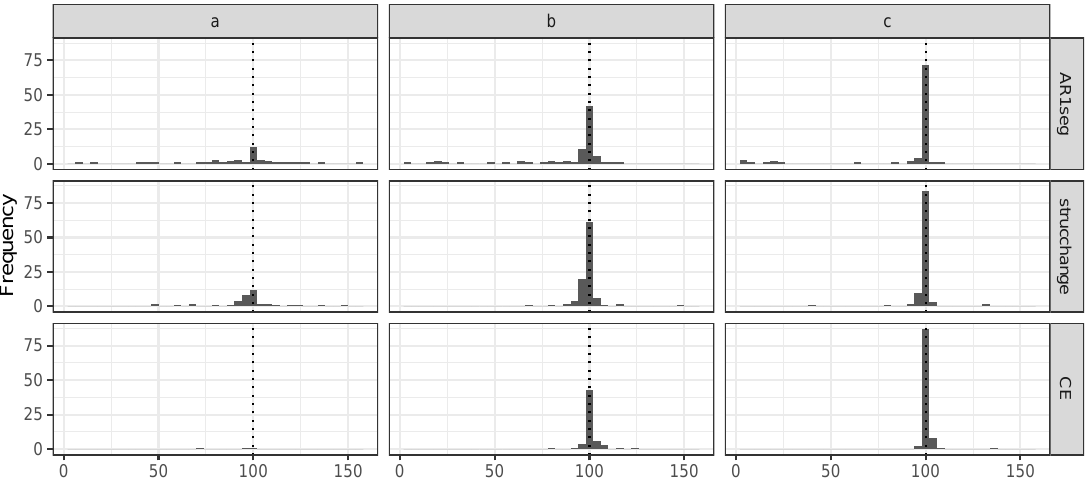
Figure 3. Frequency of the estimated locations filtered by the correct number of change-points; the true number was 100. ( a ) The results from mean shifts δ 2 = 1. ( b ) The results from mean shifts δ 2 = 2. ( c )The results from δ 2 =